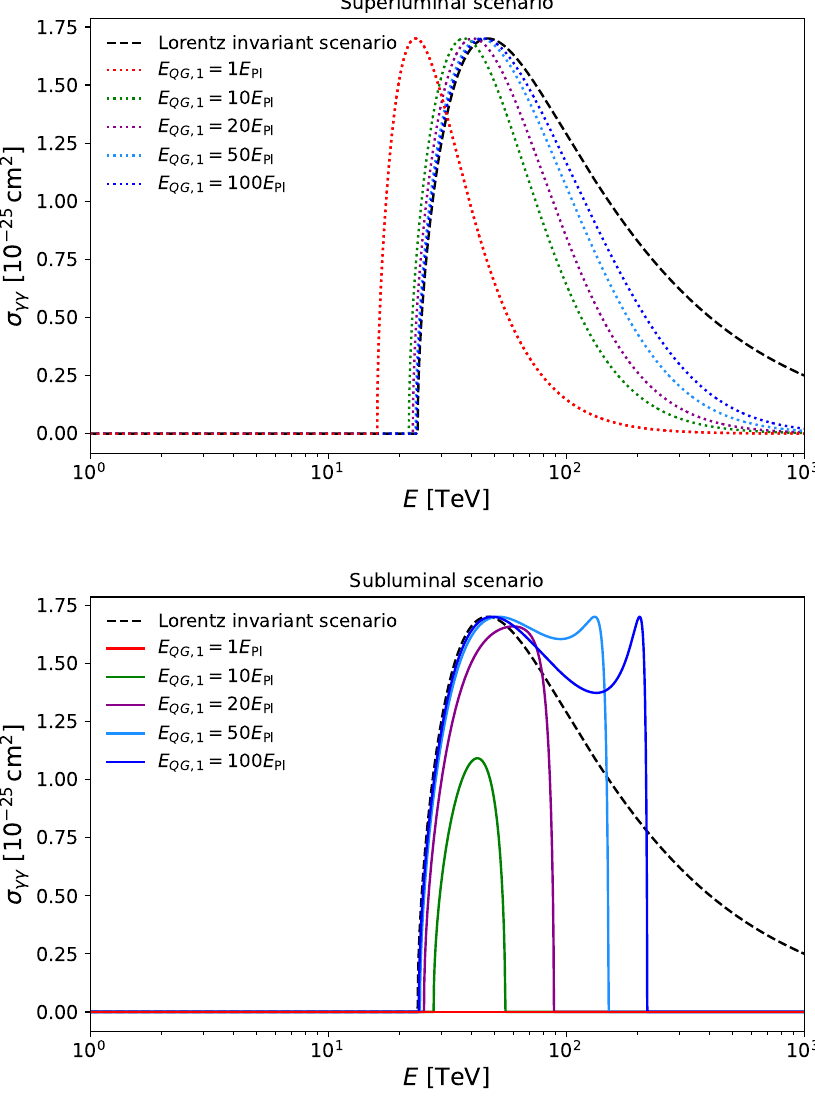
Figure 2. The Breit–Wheeler cross section as a function of the gamma-ray energy for the background photon energy of 11meV and a head-on collision. The same five values of E EG,1 as in Figure 1 were considered. ( Top ) The black dashed line represents the Lorentz invariant scenario while doted lines represent LIV superluminal scenario. ( Bottom ) The black dashed line represents the Lorentz invariant scenario while full lines represent LIV subluminal